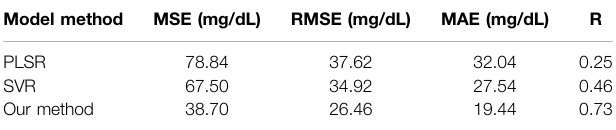
TABLE 3 | Performances of the different